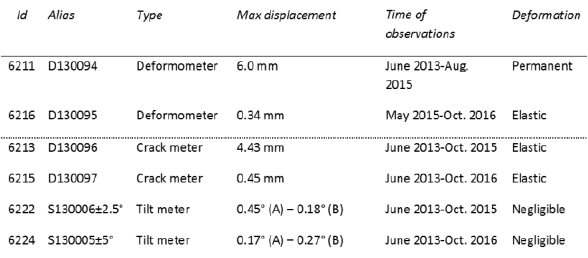
Table 2. Overview of displacement recorded by EnvEve SA sensors functioning in October 2016